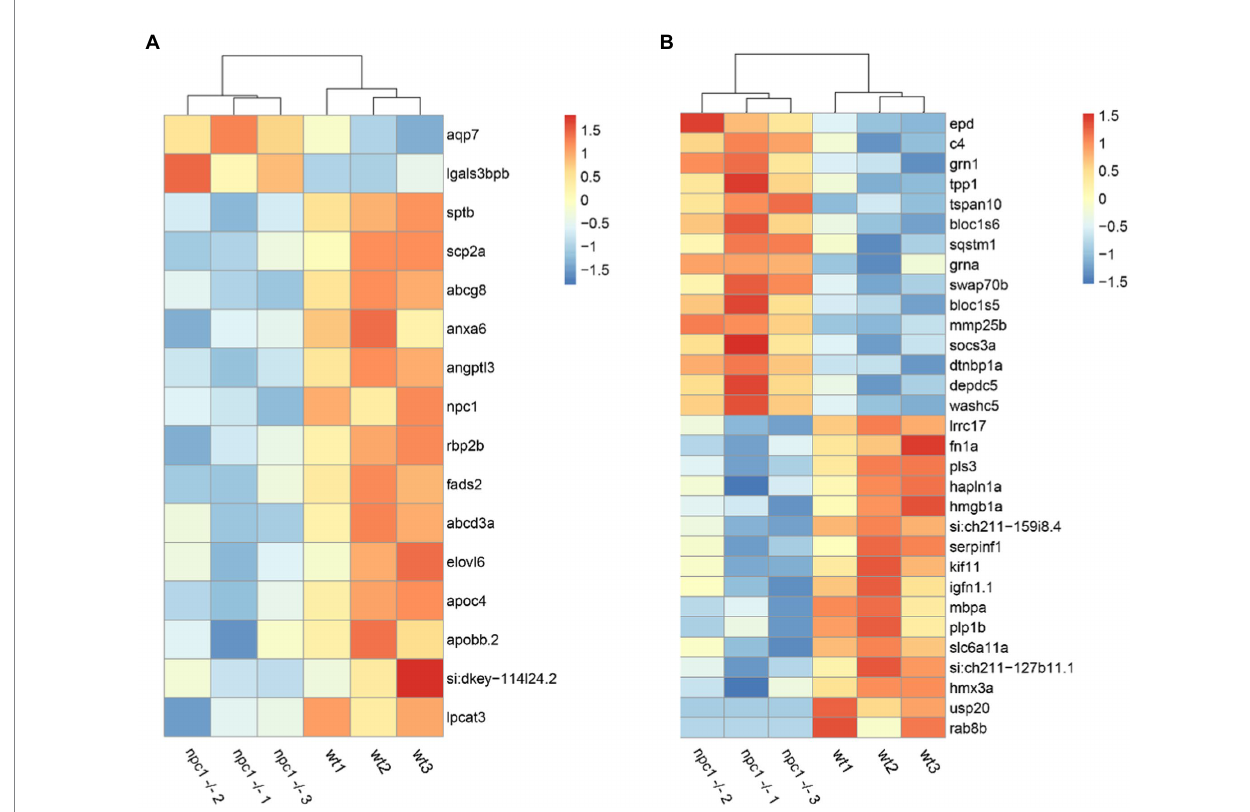
FIGURE 10 RNAseq analysis revealed differential expression between wt and npc1 Δ 56/ Δ 56 (A) Genes involved in lipid synthesis and metabolism. (B) Genes related to Central Nervous system processes. Heatmap shows the fold change of selected genes which have significant up- (positive values, orange) or down- regulation (negative values, blue).